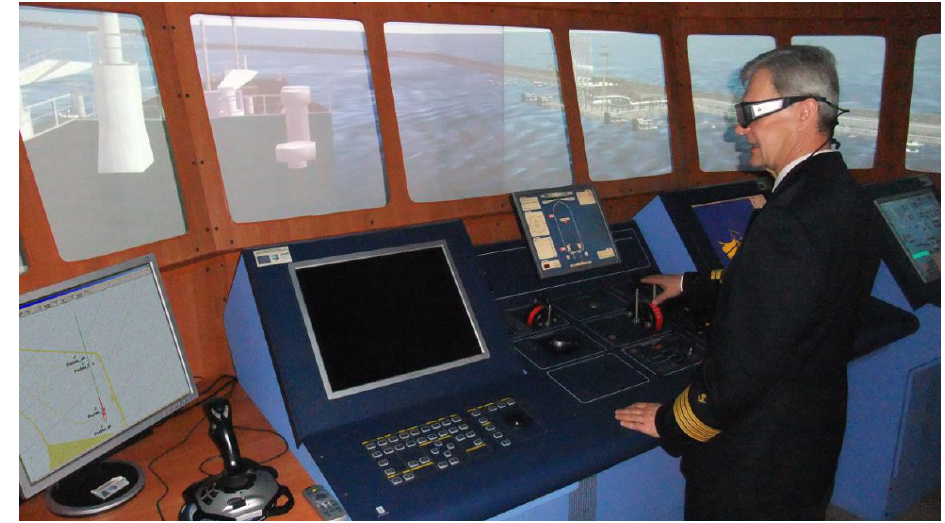
Figure 3. The use of eye-tracking technology in the research experiment.